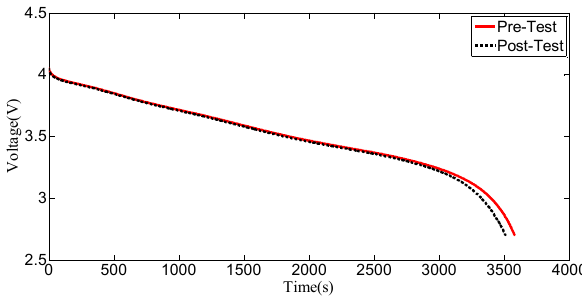
Figure 13. Discharge curves before and after vibration test.